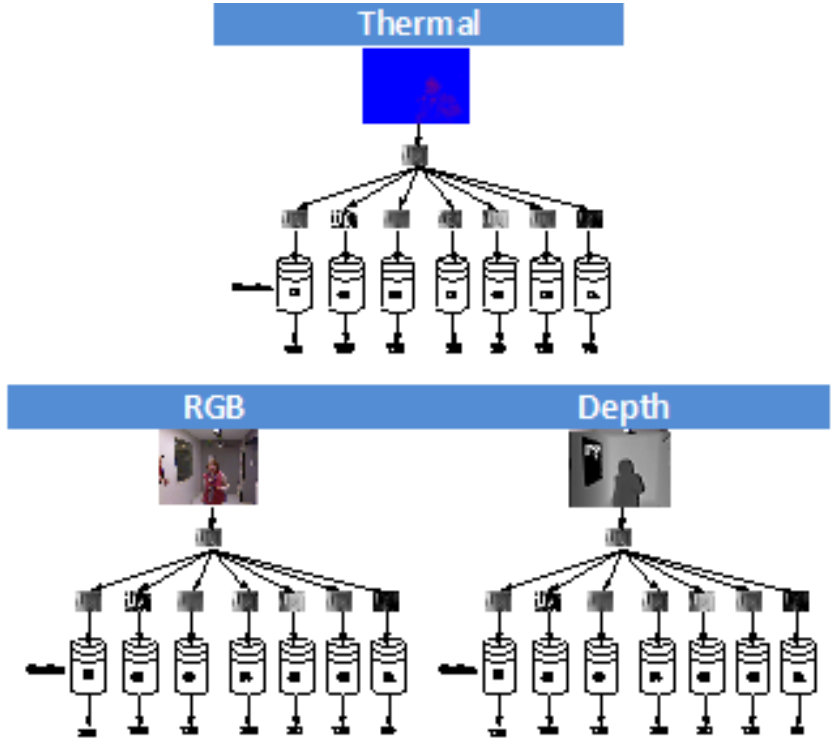
Figure 3. First phase: learning classifiers from three transformed data. Computer vision transformations over the original images are performed to enrich the input database